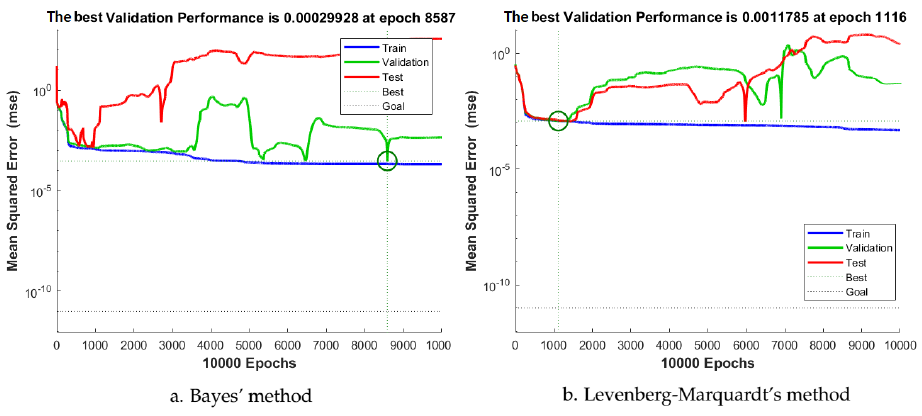
Figure 11. The observation of obtained